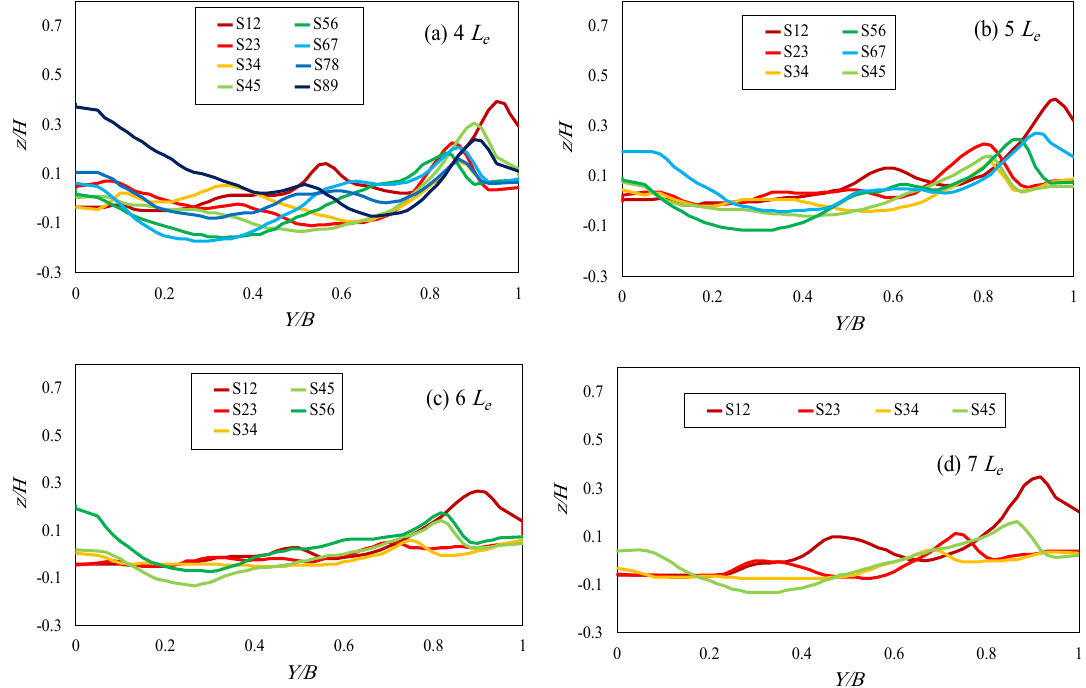
Figure 12. Cross sections between two consecutive structures at particle Froude number of 2.37. ( a ) 4 L e , ( b ) 5 L e , ( c ) 6 L e , and ( d ) 7 L e .